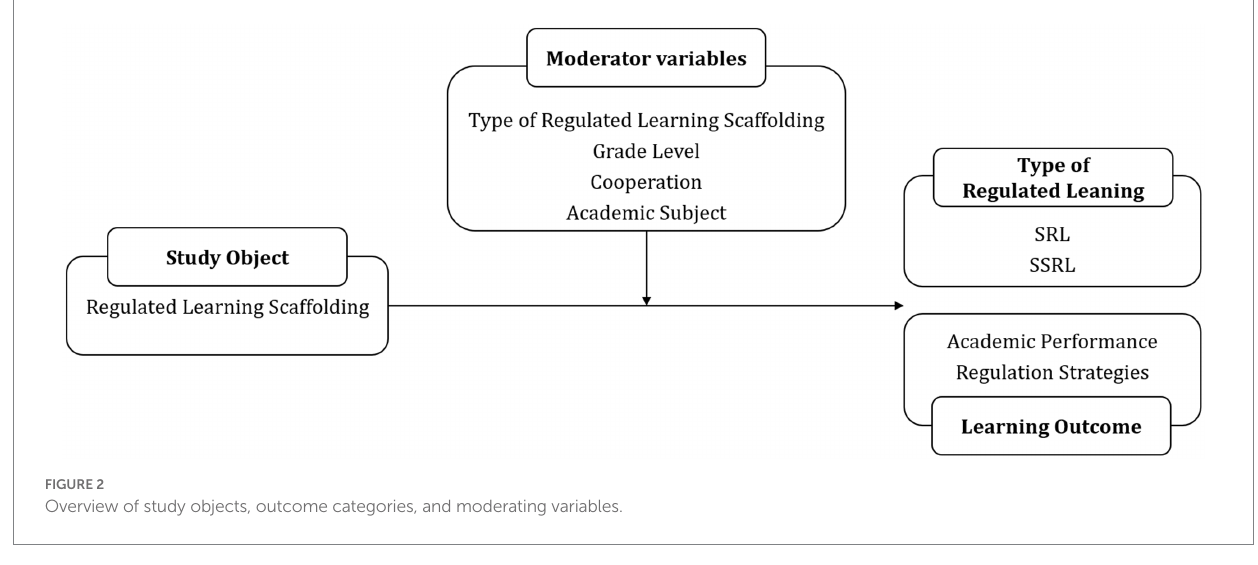
FIGURE 2 Overview of study objects, outcome categories, and moderating variables.